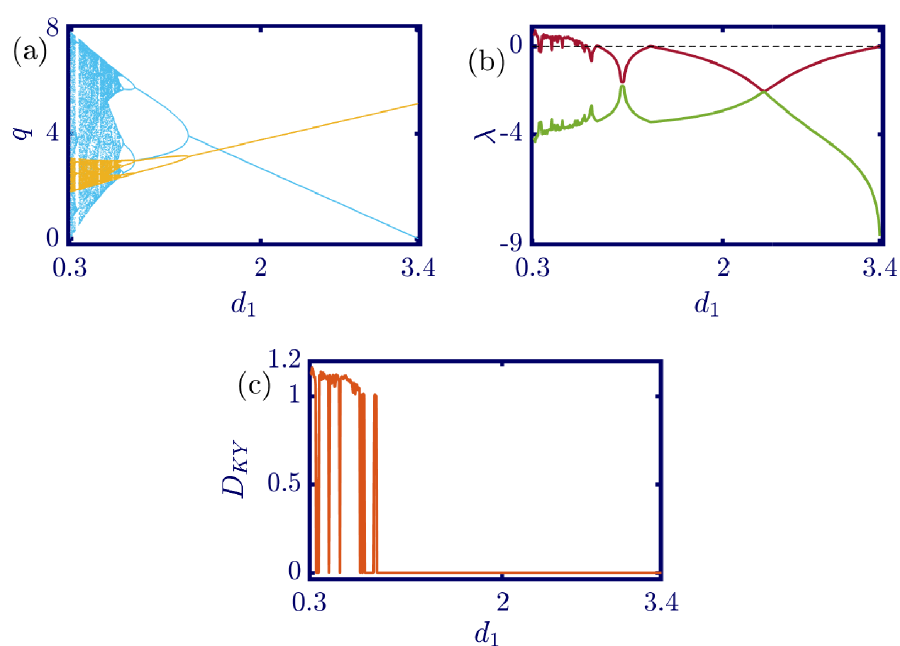
Fig 7. Eq (13) dynamics concerning the parameter d 1 with a = 6, b = 0.5, c 1 = 2, c 2 = 1, d 2 = 1, v 1 = 0.1, v 2 = 1 and initial conditions q 1 (0) = q 2 (0) = 1. (a) Bifurcation diagram, (b) Lyapunov exponents spectra, and (c) Kaplan-Yorke dimension. A periodic halving route to chaos is observed by changing the marginal cost of the leader firm. As a result, avoiding a chaotic and unstable market requires selecting a sufficiently large value for marginal cost. This marginal cost acts like a punishment in the company’s cost function and forces it to converge to the Nash equilibrium. In the sub-figure (a), the cyan points represent the data for the leader firm ( q 1 ), whereas, the yellow points represent those for the follower firm ( q 2 ), and in sub-figure (b), the red and green points present the Lyapunov exponent spectra for the leader and follower firms respectively, namely λ 1 and λ 2